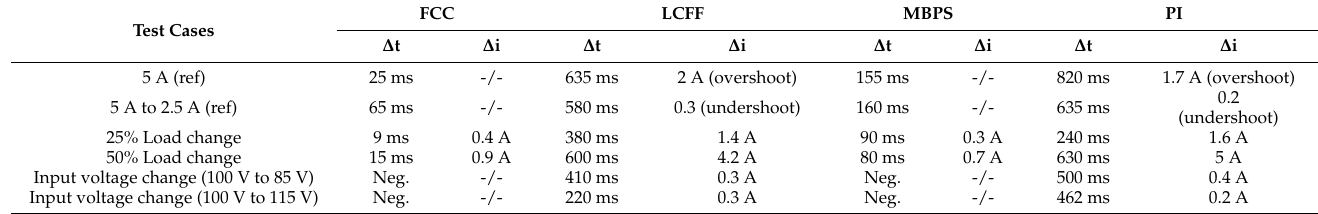
Table 2. Summary of MATLAB simulation results.